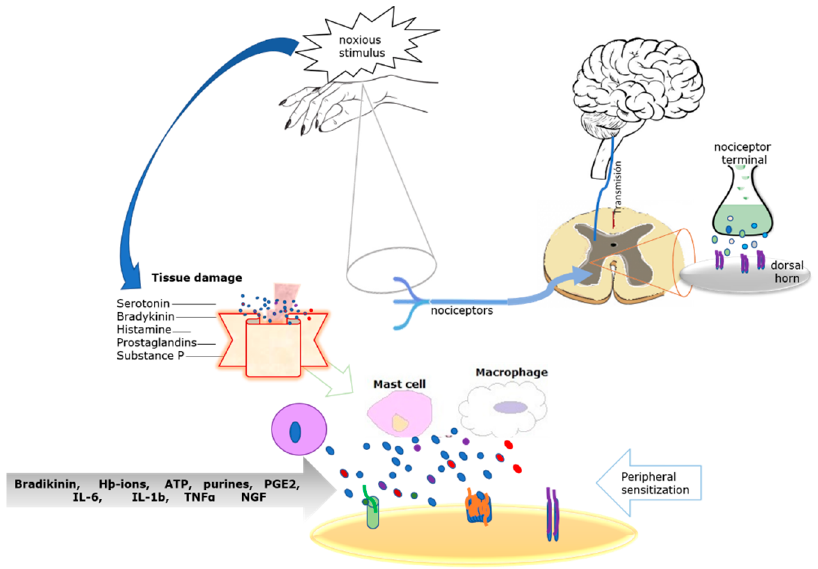
Figure 1. Diagram of the process of pain and peripheral sensitization leading to inflammatory